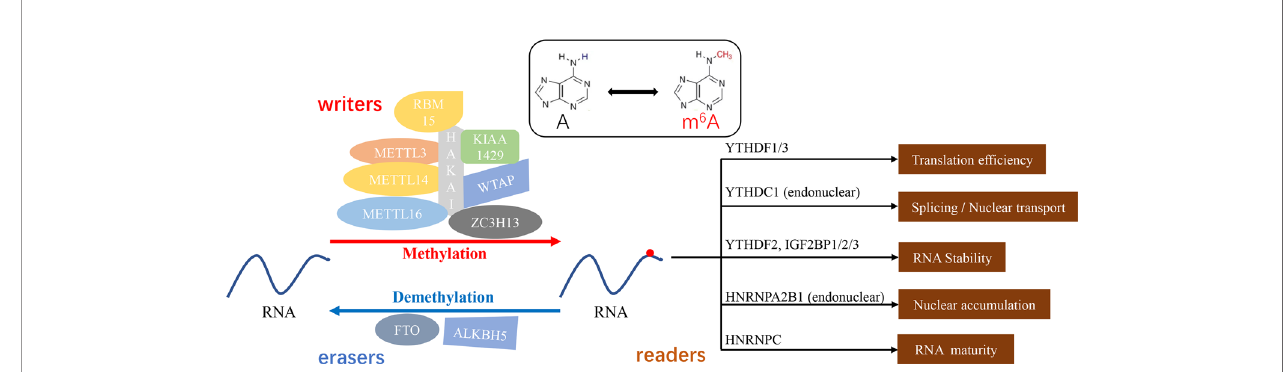
FIGURE 1 | m 6 A methylation - a dynamic and reversible “ chemical reaction ” . “ Writers ” (METTL3/14/16, KIAA1429, WTAP, RBM15, ZC3H13, and HAKAI) or “ erasers ” (FTO, ALKBH5) mediate the process of methylation or demethylation. Furthermore, the function of modi fi ed substrates depends on the distinguishingly bounded “ readers ” (YTHDF1/2/3, YTHDC1, IGF2BP1/2/3, HNRNPA2B1,